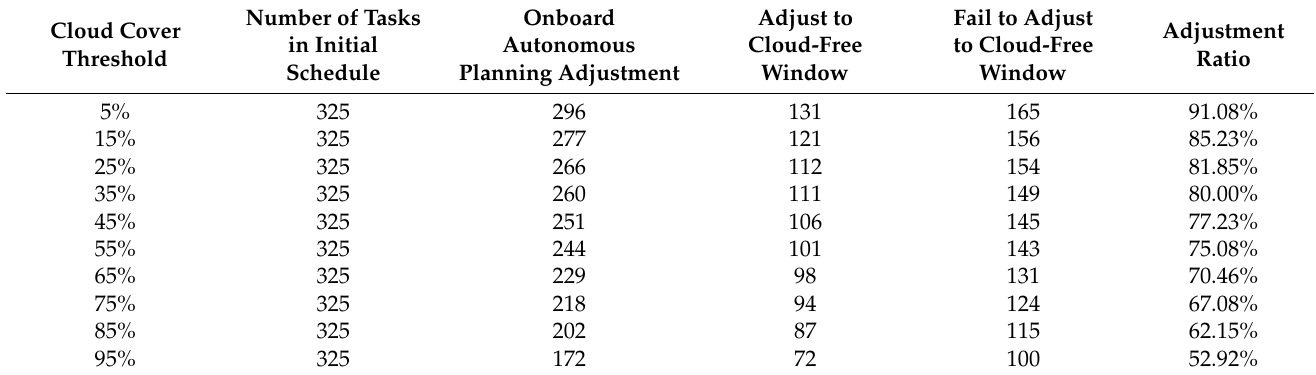
Table 5. Influence of cloud cover thresholds on onboard autonomous